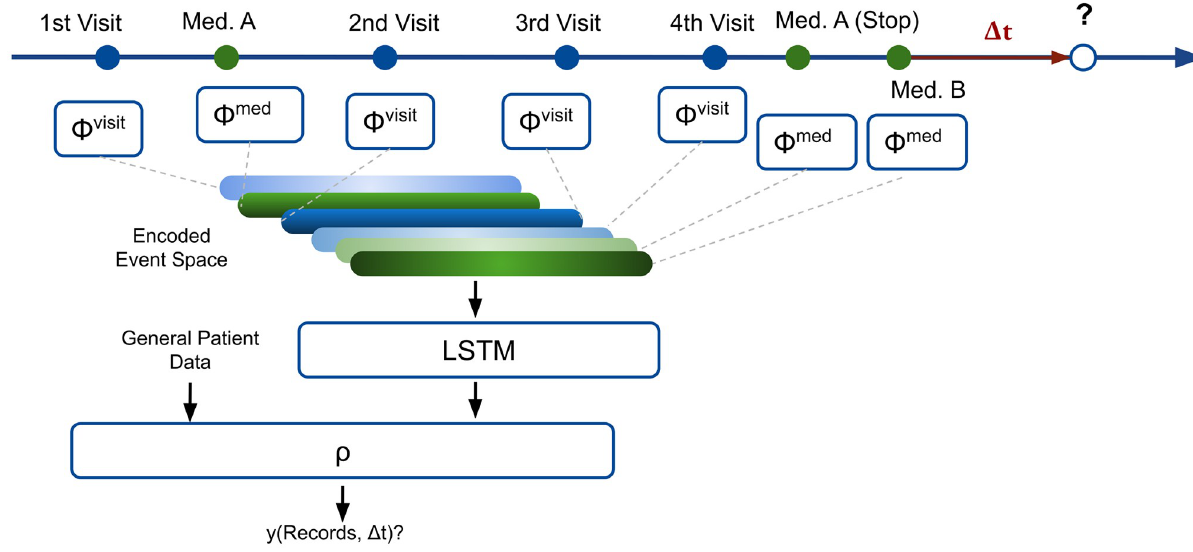
Fig 1. Deep neural network architecture (AdaptiveNet). All visits and medication adjustments are projected to latent vectors of the same size using encoder networks ϕ visits and ϕ meds . Latent vectors are sorted according to dates and fed into a Long Short-term Memory (LSTM) to create a latent vector describing the full patient history. The final prediction is computed by the network module ρ , exploiting the patient history with general patient information.